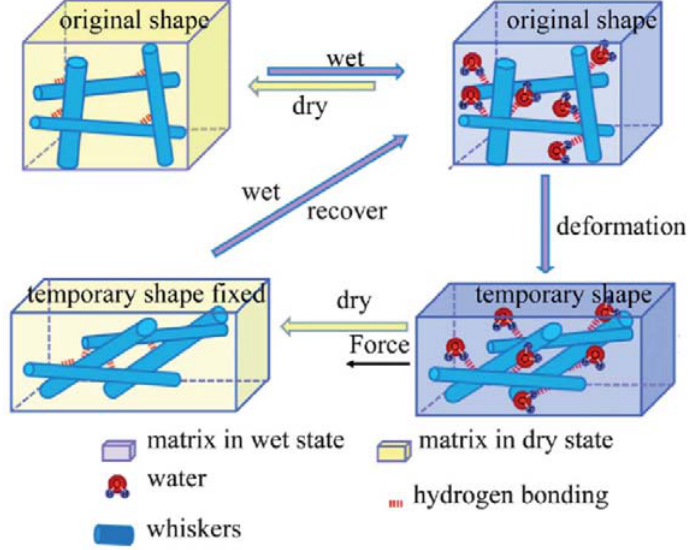
Figure 22. Proposed rapidly switchable water-sensitive shape-memory mechanism for the cellulose nanowhiskers/PUs comprising a cellulose nanowhiskers percolation network in an elastomeric matrix. Reprinted with permission from [117]. Copyright 2012 Royal Society of